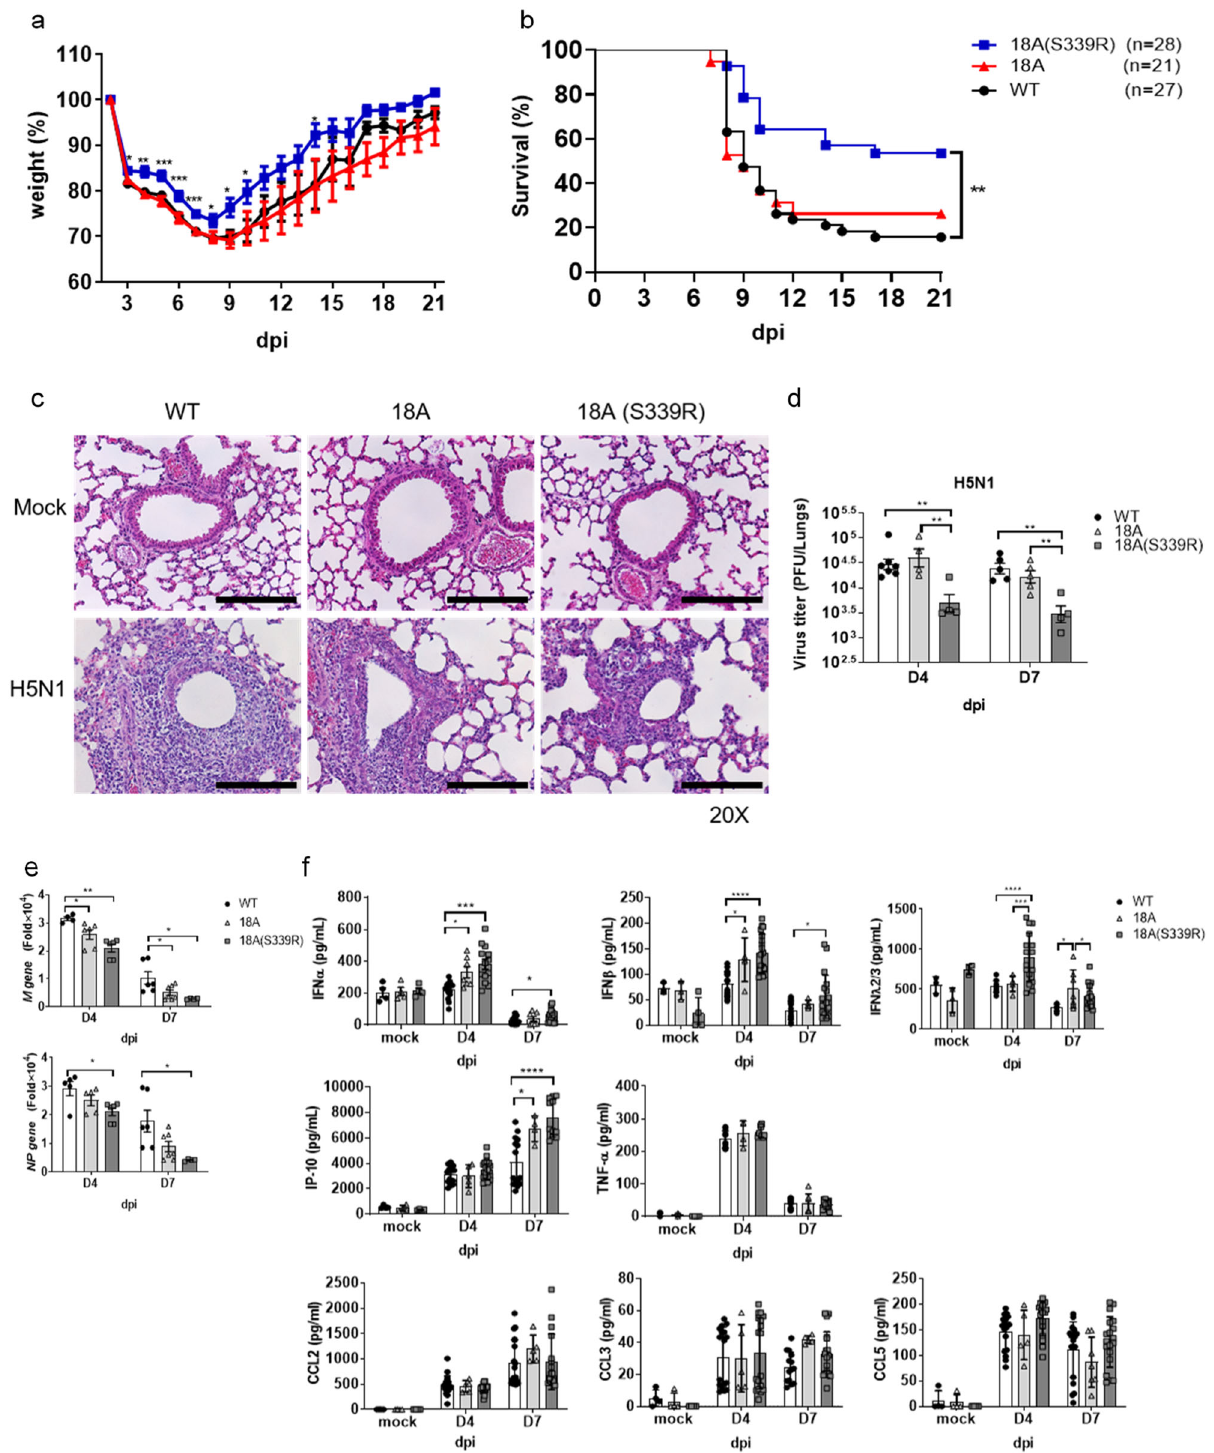
Fig. 8 CLEC18A and CLEC18A(S339R) protect host from IAV-induced in fl ammation and lethality. a , b WT, ROSA-CLEC18A, and ROSA-CLEC18A (S339R) mice were inoculated with H5N1 virus (1.5 × 10 3 PFU) by intranasal route to observe body weight changes ( a ) and survival rate ( b ) ( n = 21 – 28). c Lung tissues harvested at day 4 post infection were subjected to hematoxylin and eosin staining ( n = 3). d , e Virus titer in lung tissues was determined by plaque assay ( n = 4 – 6) ( d ), while viral structure gene expression (M and NP) was determined by RT-PCR ( n = 4 – 6) ( e ). f Cytokines contained in the bronchial alveolar lavage fl uid (BALF) from WT and ROSA-CLEC18A/CLEC18A(S339R) mice at days 4 and 7 post infection were determined by ELISA ( n = 3 – 17). d.p.i. days post infection. One-way ANOVA was performed. * P < 0.05, ** P < 0.01, *** P < 0.001 and **** P < 0.0001 for WT group versus group of CLEC18A or CLEC18A(S339R). Scale bar: 200 μ